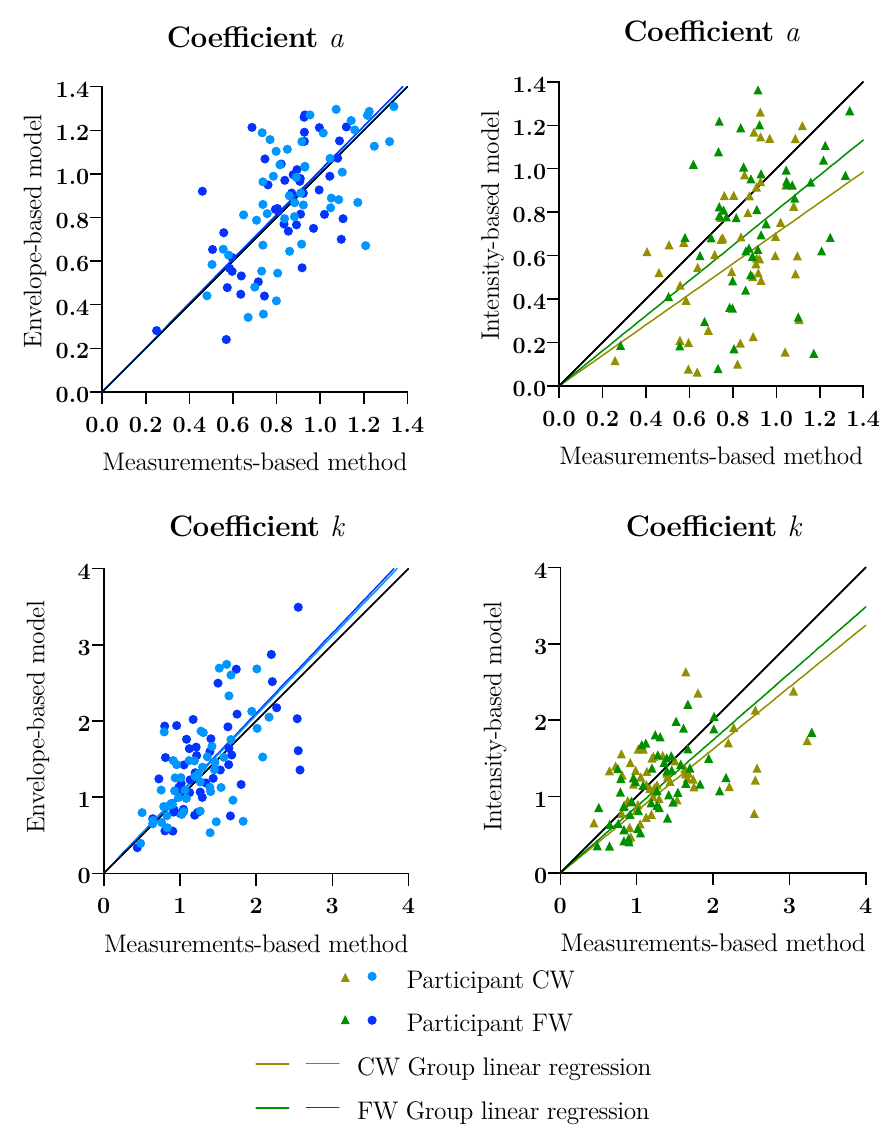
Figure 4. Comparison of the individual compression coefficients a (above) and k (below) between the rendering method based on measurements and the models. On the left , the envelope-based model (blue). On the right , the intensity-based model (green). Dark symbols correspond to parameters estimated from participants of the FW group, and light symbols are of the CW group. Dark lines correspond to the regression curves associated with the FW group, and light lines correspond to the CW